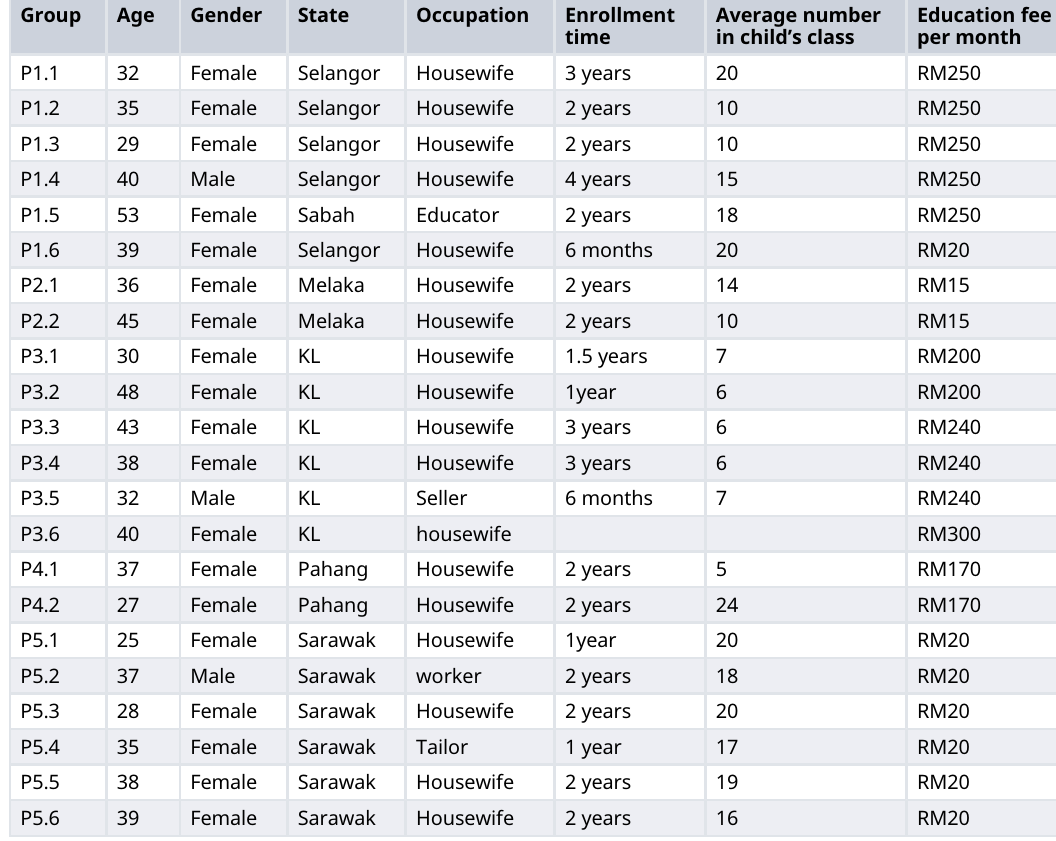
Table 4. Demographics of respondents in focus group interviews (Malaysia, author source data).